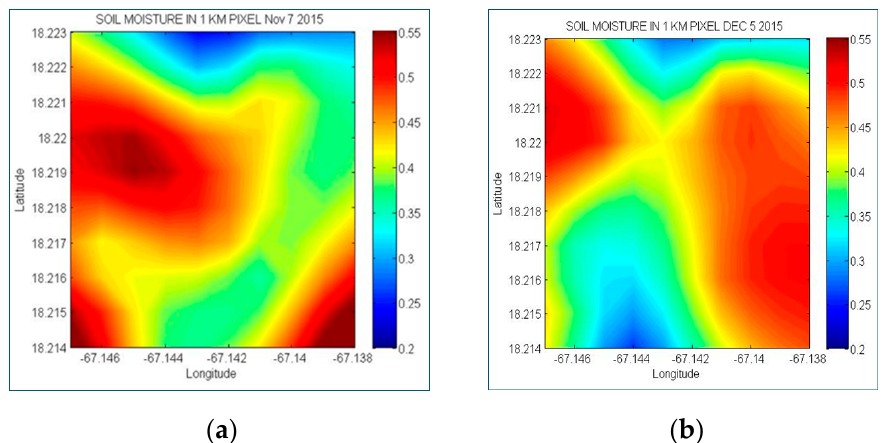
Figure 3. Volumetric soil moisture content within 1 km 2 GOES Satellite pixel, based on 13 soil samples collected on 7 November 2015 ( a ) and 5 December 2015 ( b ). Measured and Simulated Soil Moisture October through December 2015